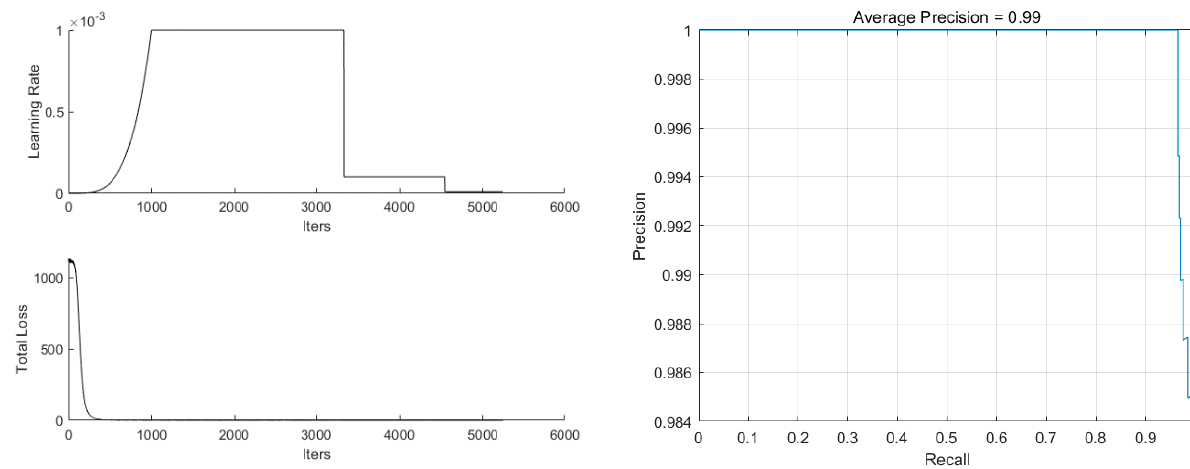
Figure 7. Training status of IRM-YOLOv2.